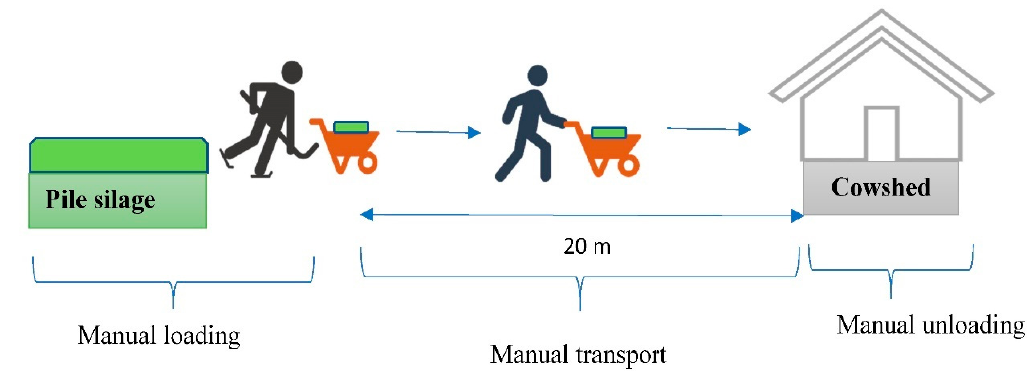
Figure 2. Diagram of activities for which measurements were performed.